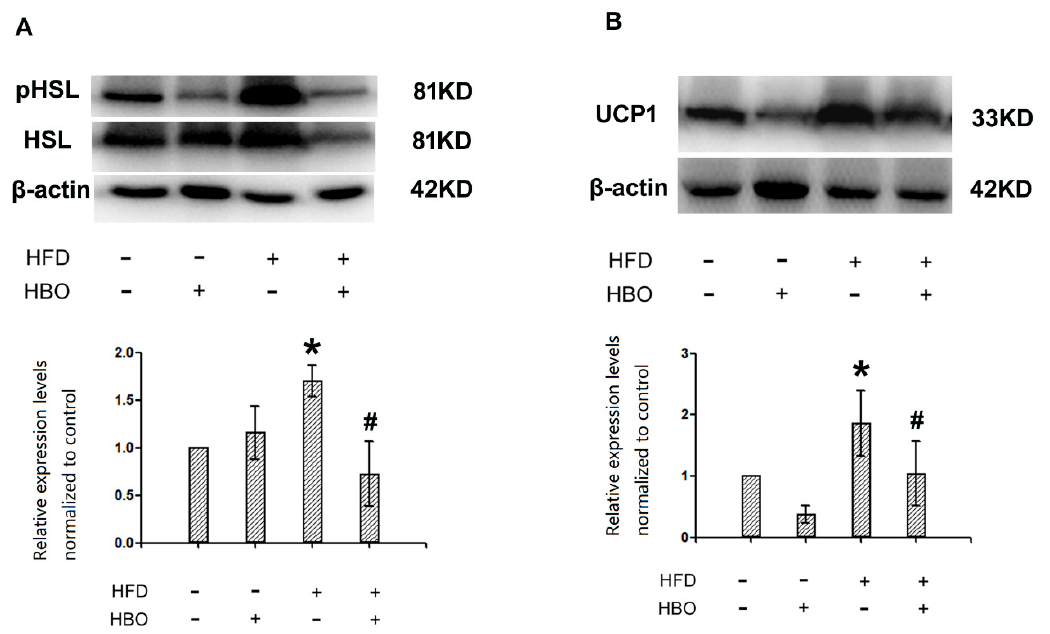
Figure 8. Western blotting for pHSL / HSL and UCP1 in brown adipose tissues. Brown adipose tissues from C57 / B6 mice were homogenized in RIPA bu ff er with 1:100 PMSF and 1:100 phosphatase inhibitor cocktails, centrifuged at 14,000 × g for 10 min, and the resulting supernatants were subjected to western blotting analysis for pHSL / HSL and UCP1. Images were acquired from a Vilber Lourmet gel imaging system and analyzed with ImageJ. Three samples from independent animals were included per group. Error bars represent standard derivation. ( A ): Representative blot images and quantifications of pHSL / HSL. ( B ): Representative blot images and quantifications of UCP1. *: statistically di ff erent from control group animals ( p < 0.05). #: statistically di ff erent from HFD group animals ( p <